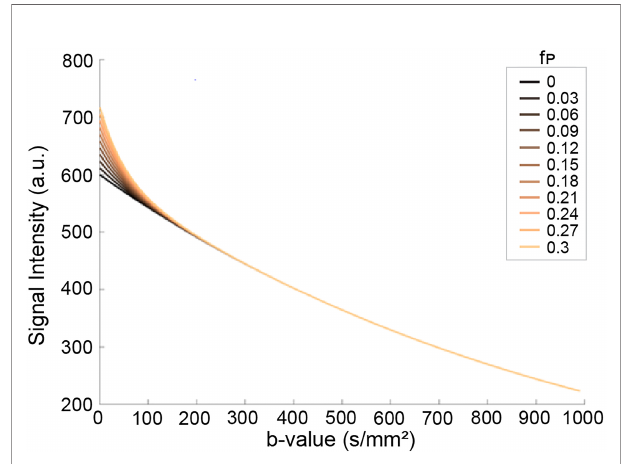
FIGURE 6 | Effects of pseudo-diffusion on DWI signal. Signal curves in the presence of increasing IVIM effects deviate from the simple mono-exponential curve (f p =0, black line). The components have unique coef fi cients D t = 0.001 s/mm 2 and D* = 0.02 s/mm 2 with relative proportions given by the pseudo- diffusion fraction f p (164). (Courtesy of Igor Vidic ́ , PhD, previously at the Department of Physics, Norwegian University of Science and Technology, Trondheim,